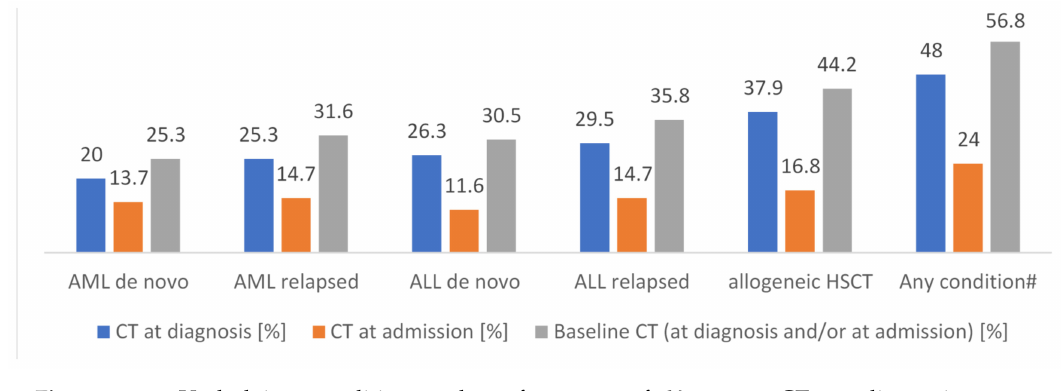
Figure 3. Underlying condition and performance of X-ray or CT at diagnosis or at admission, respectively—defined as Baseline CT; n = 95. # Numbers are super-additive.